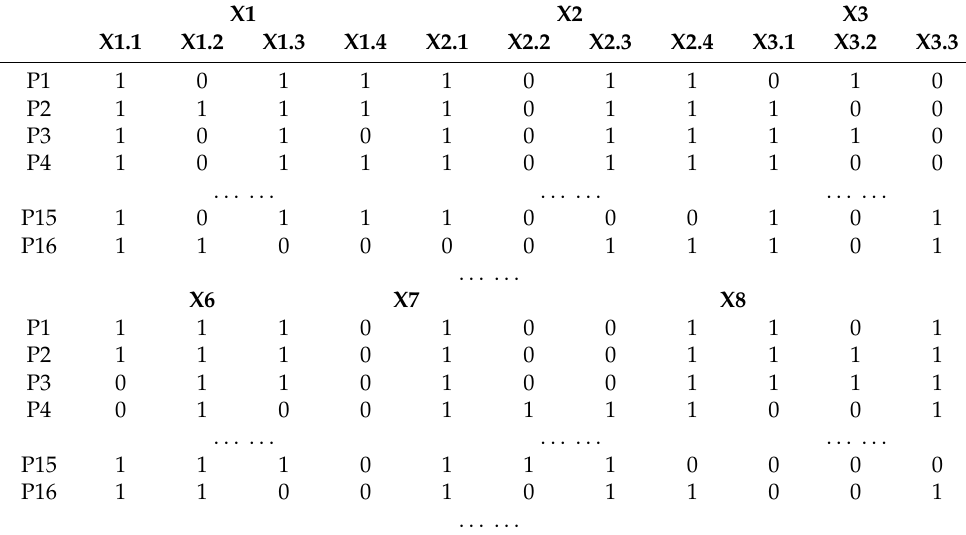
Table 4. Input–output policy table.